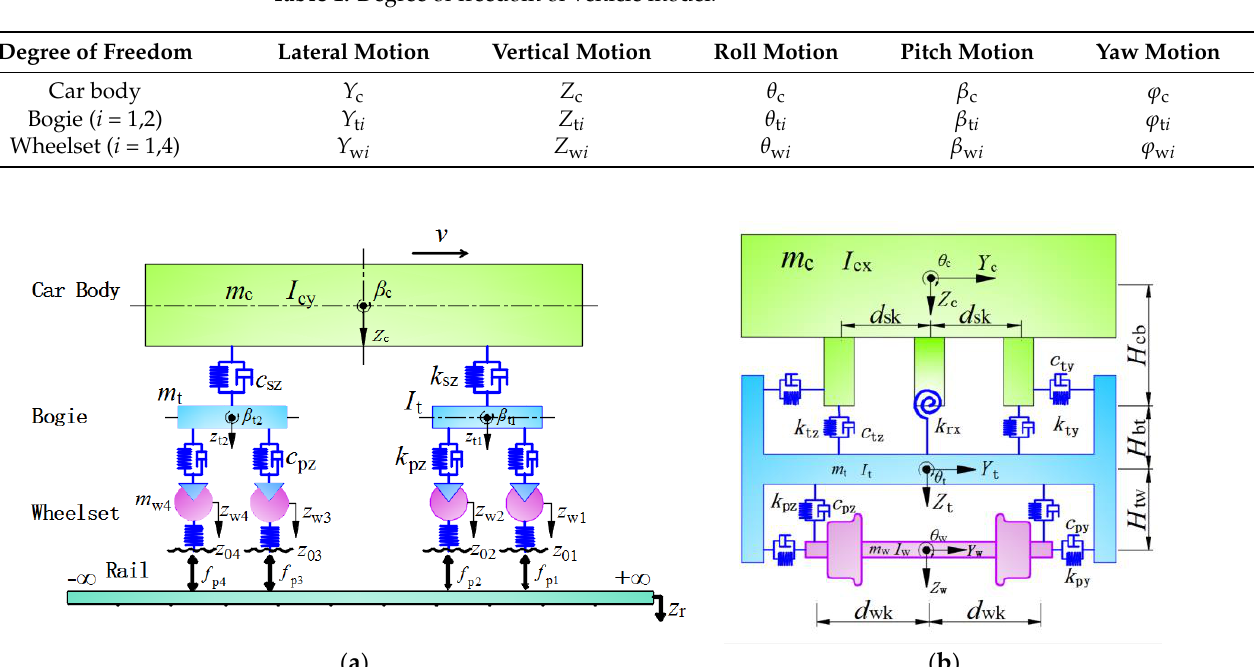
Figure 1. Track geometric irregularity and cross-section arrangement of HSR with ballast track. ( a ) Wave of track geometric irregularity. ( b ) Diagram of cross − section arrangement.